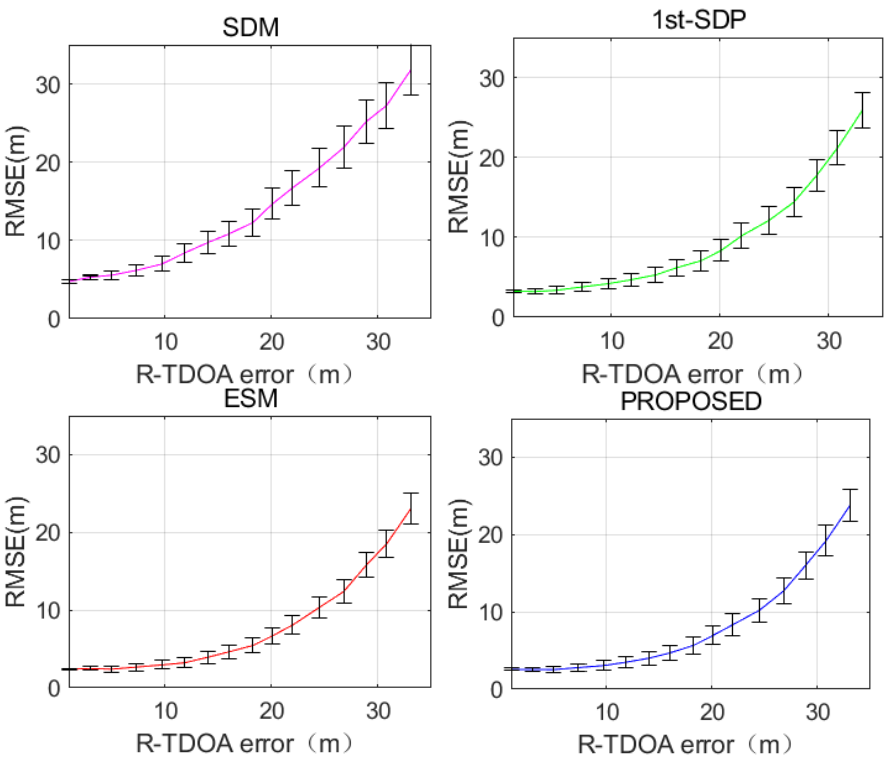
Figure 11. RMSE curve of each method with error bars ( N = 25).